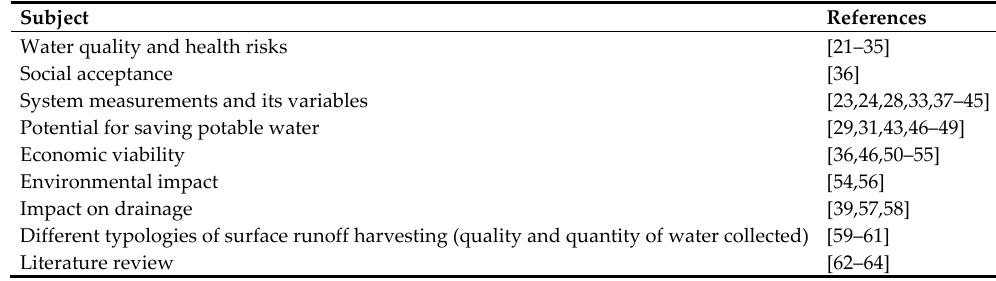
Table 1. Subjects covered by the theses and dissertations obtained from Protocol 2 and considered in our